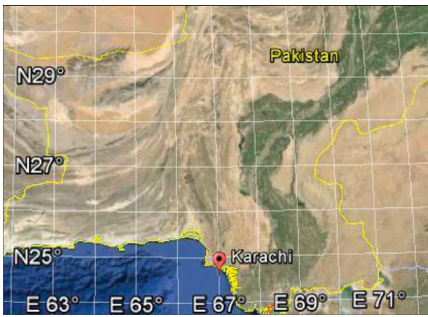
Figure 1: Map showing location of Karachi (data source: Google